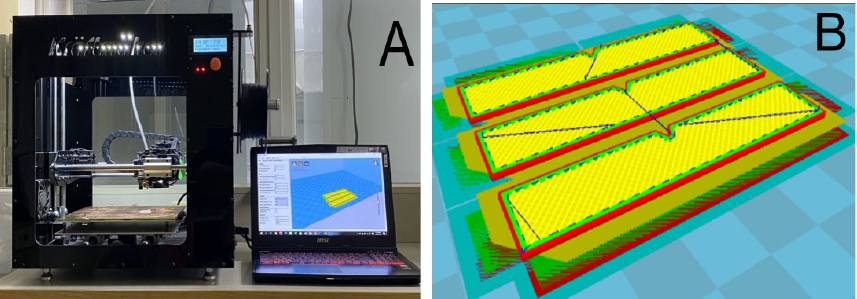
Figure 1. ( A ) Photo of the fused deposition modelling (FDM) printer; ( B ) the Cura interface used to control the printing process.